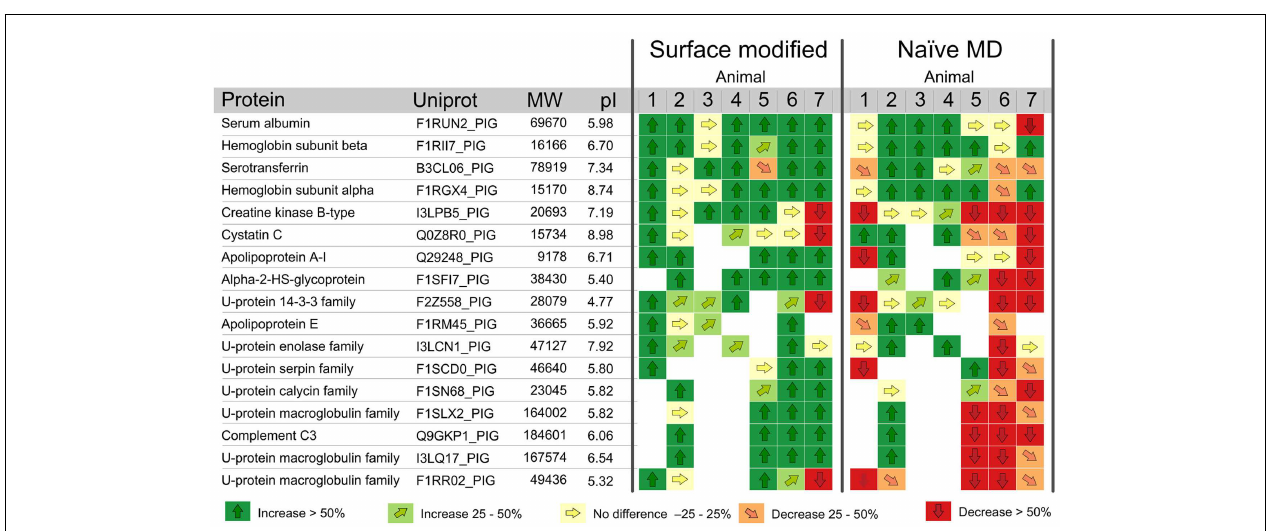
protein has increased significantly in concentration by > 50% due to the intervention. An arrow pointing straight down ( ↓ ) means that the concentration of the protein has decreased significantly by > 50% in response to the intervention.Vectors pointing diagonally display either an increase (light green) or a decrease (orange) of 25–50%.These changes are not statistically significant but they show interesting tendencies. Finally, vectors pointing to the right (yellow) range between 0.75 and 1.25 and show no significant difference between the two fractions. U-protein means uncharacterized proteins. White boxes means that the protein was not identified or quantified in the sample.Thus, a white box is a reflection of the sample composition, not related to MD catheter performance (16). Reprinted with permission from Dahlin et al. (16). Copyright American Chemical